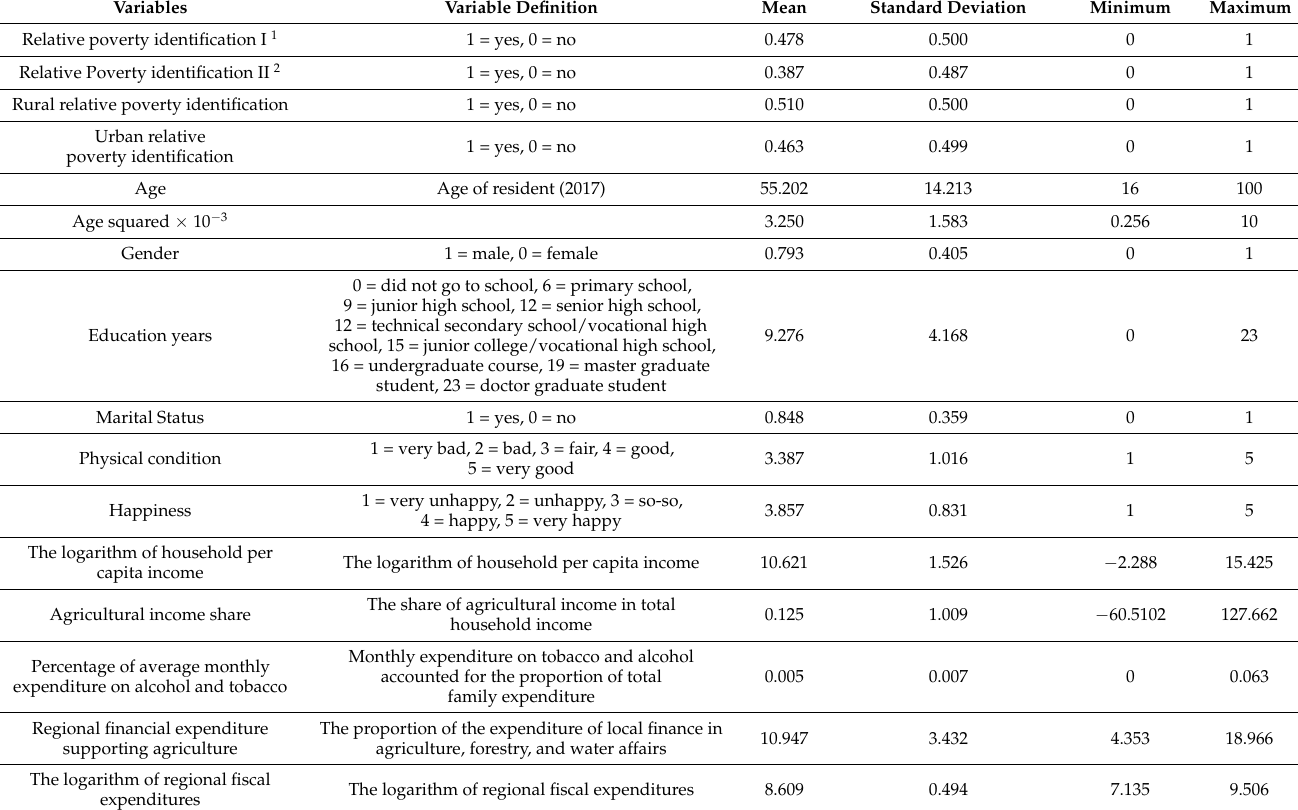
Table 6. Statistical analysis of each